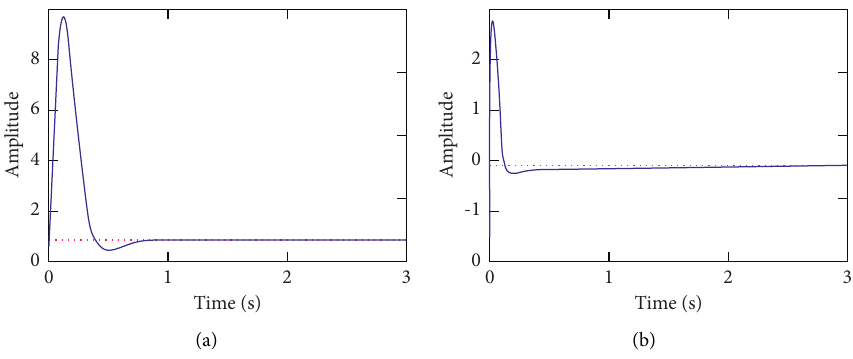
Figure 8: Response curve of e